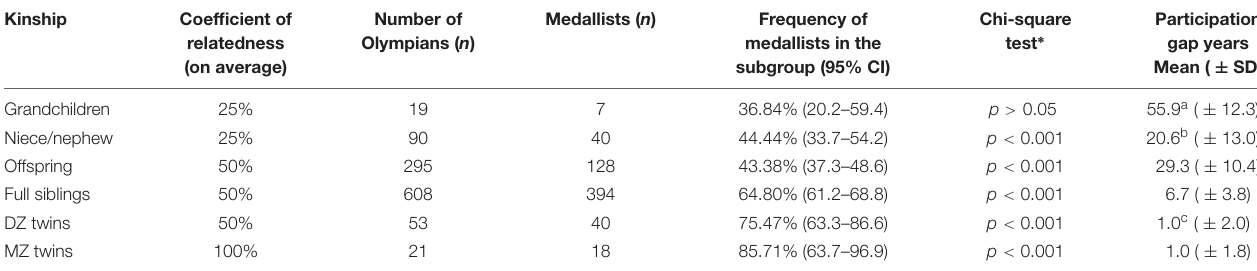
FIGURE 1 | Frequencies (%) ( ± 95% CI) of Medallists having a grandparent, aunt/uncle, parent or siblings in the Olympic Games that were non-medallists (gray bars, dotted line) and that were Medallists (solid bars), in a different sport (red bars) or in the same sport (green bars). ∗ § Frequency of Medallists significantly different ( p < 0.001) in relation to the expected probability (20.37%). TABLE 1 | Frequency of medallists according to a kinship status with a former Olympic